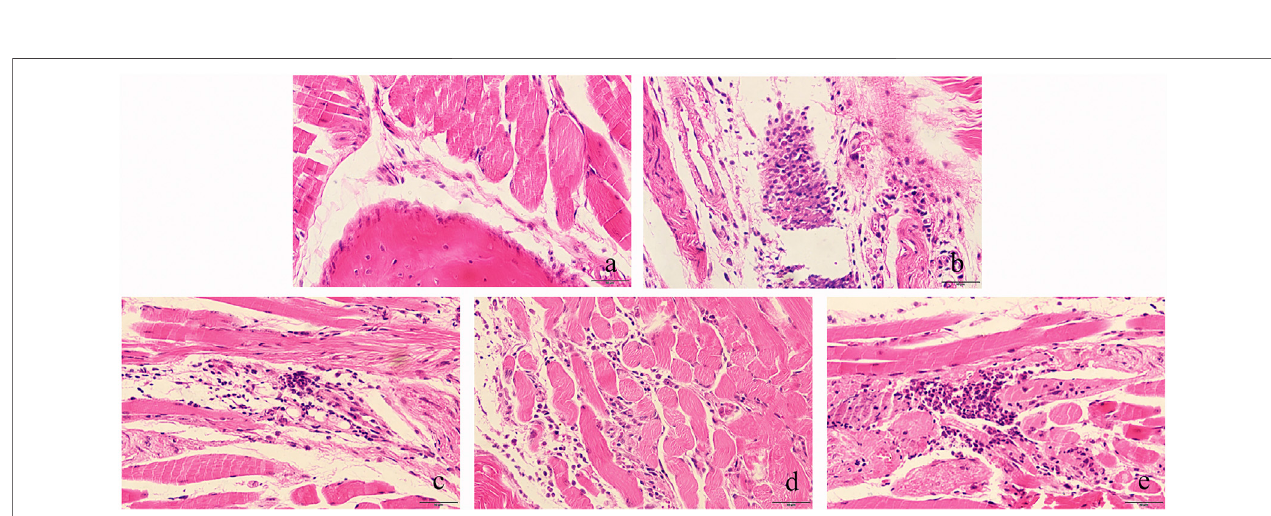
FIGURE 13 | Representative picture of HE staining of the right footpad at plantar side (200 × ). In fi ltrated neutrophils in the hind foot tissue appear as purple dots in HE staining. (A) , Normal control group; (B) , MSU control group; (C) , colchicine group; (D) , TF-400 mg/kg group; (E) , AM-80 mg/kg group. TF fl avonoid extract; AM, amento fl